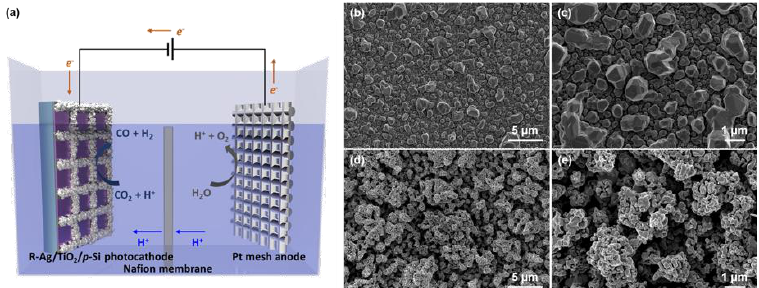
Figure 1. ( a ) Schematic of the proposed photoelectrochemical reduction of CO 2 into syngas on R-Ag / TiO 2 / p -Si photocathode. Scanning electron microscopic (SEM) images of ( b , c ) Ag catalysts on TiO 2 / p -Si photocathode and ( d , e ) R-Ag catalysts on TiO 2 / p -Si photocathode.